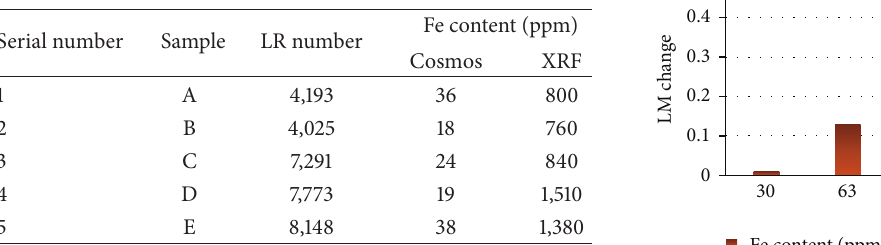
Table 3: Results of the realized experiments.